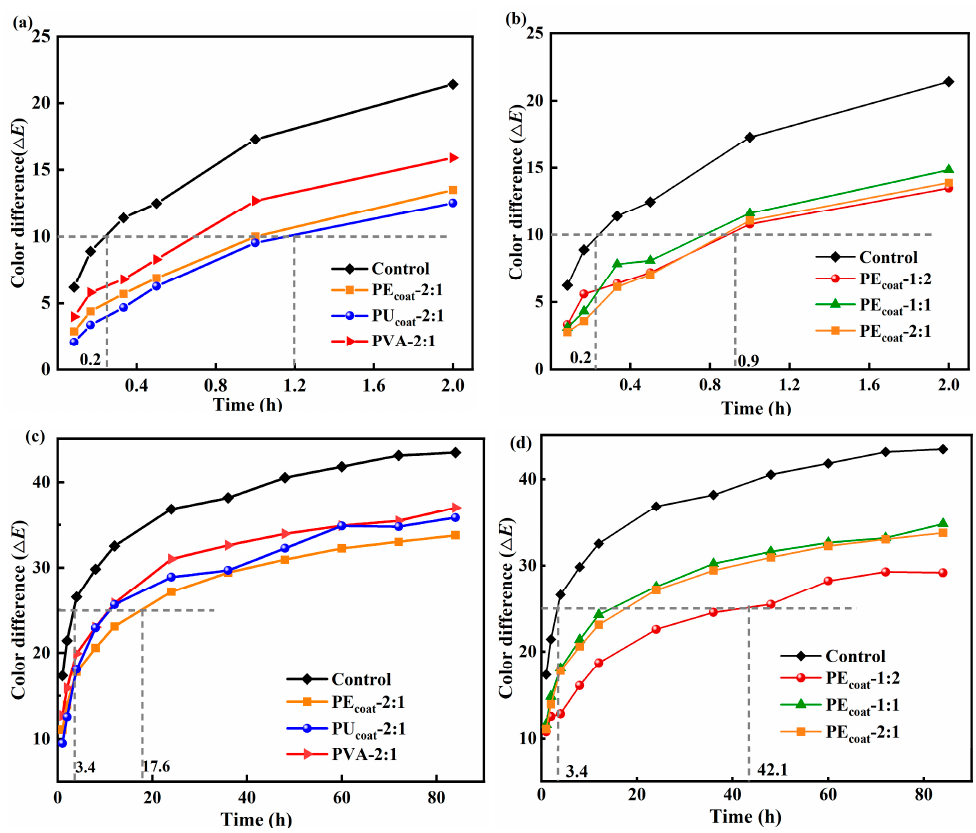
Figure 11. Changes in color difference of coatings affected by UV under different formu- lations: ( a , c ) samples coated with different resins; ( b , d ) samples coated with different resin loadings.